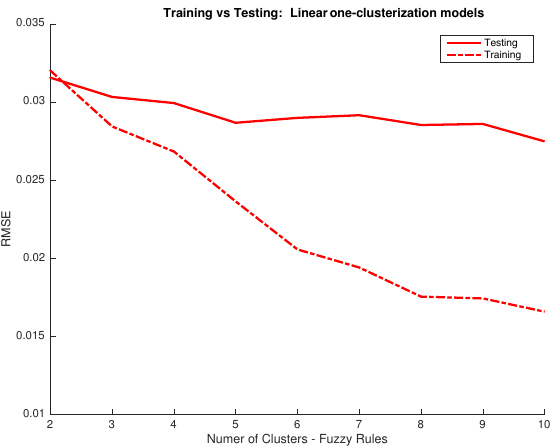
Figure 10. RMSE between predictions from the FIS system and desired outputs in the RGB training dataset (y axis) vs. number of clusters used (x axis). Legend indicates for each plot if the same input clusterization is used for all outputs or not.